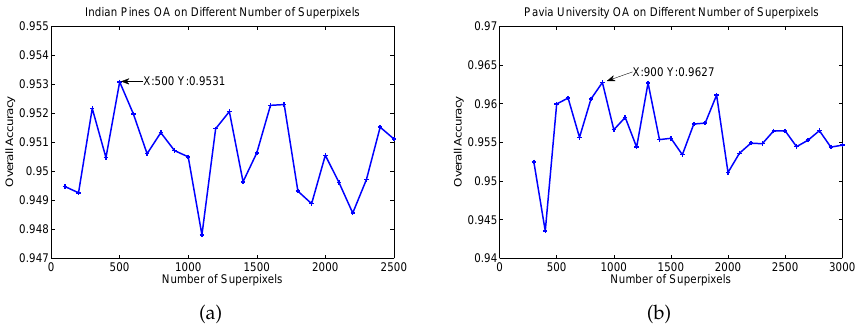
Figure 4. Overall classification accuracies for different numbers of superpixels. ( a , b ) show the OA versus different numbers of superpixels on the Indian Pines and Pavia University datasets,